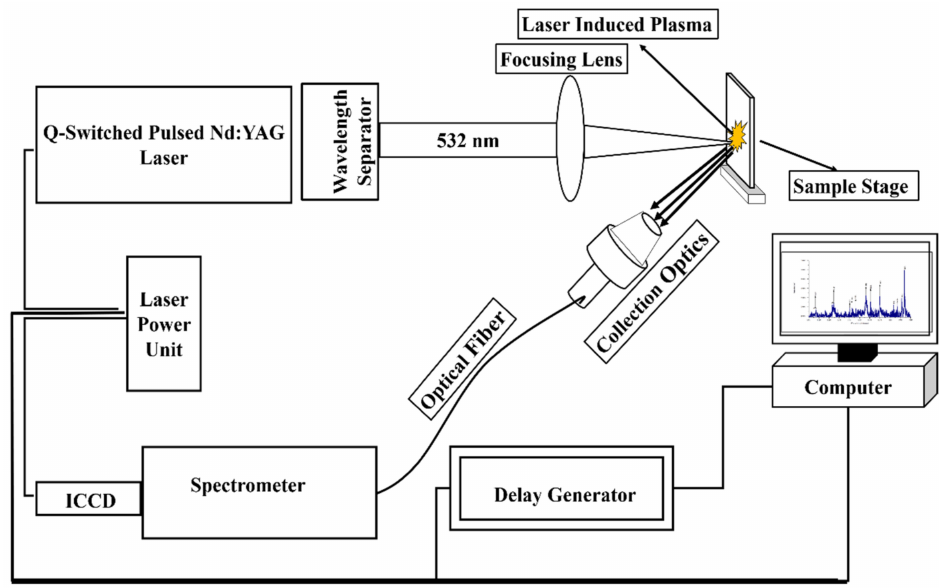
Figure 1. Schematic diagram of Laser